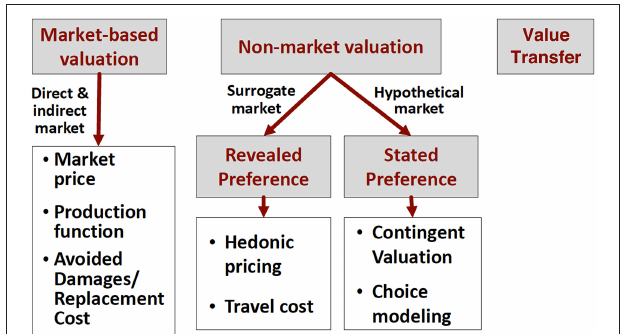
FIGURE 12 | Schematic classification of the different methods that have been developed for the monetary valuation of ecosystem